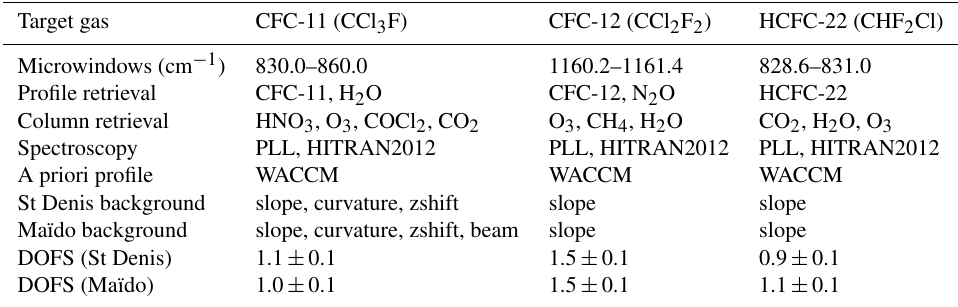
Table 1. Microwindows, interfering gases, spectroscopic database, a priori profile and background parameters (slope, curvature, zshift and beam as discussed in Sect. 2.2.1) used for the SFIT4 retrievals of CFC-11, CFC-12 and HCFC-22. The degree of freedom for signal (DOFS, mean and standard deviation) of retrievals at St Denis and